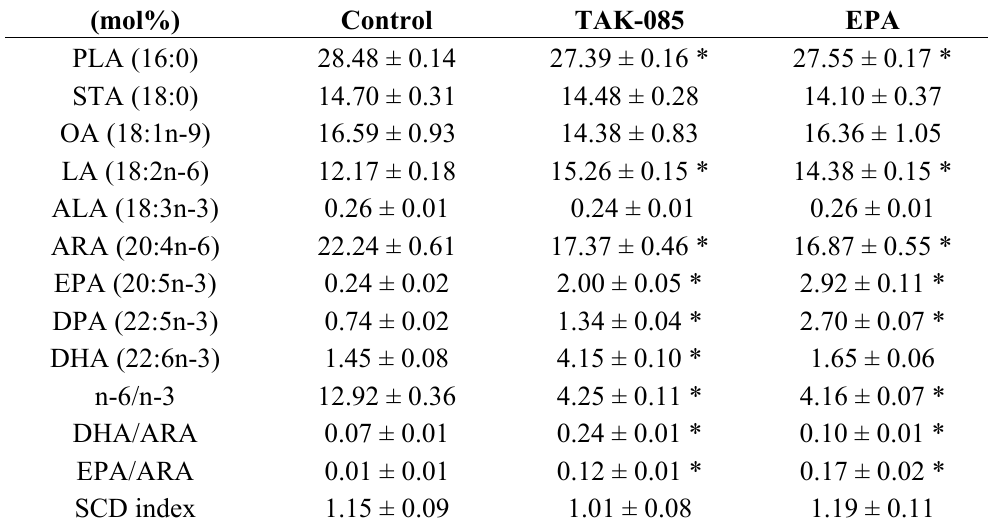
Table 4. Effects of TAK-085 and EPA on fatty acid profiles in the